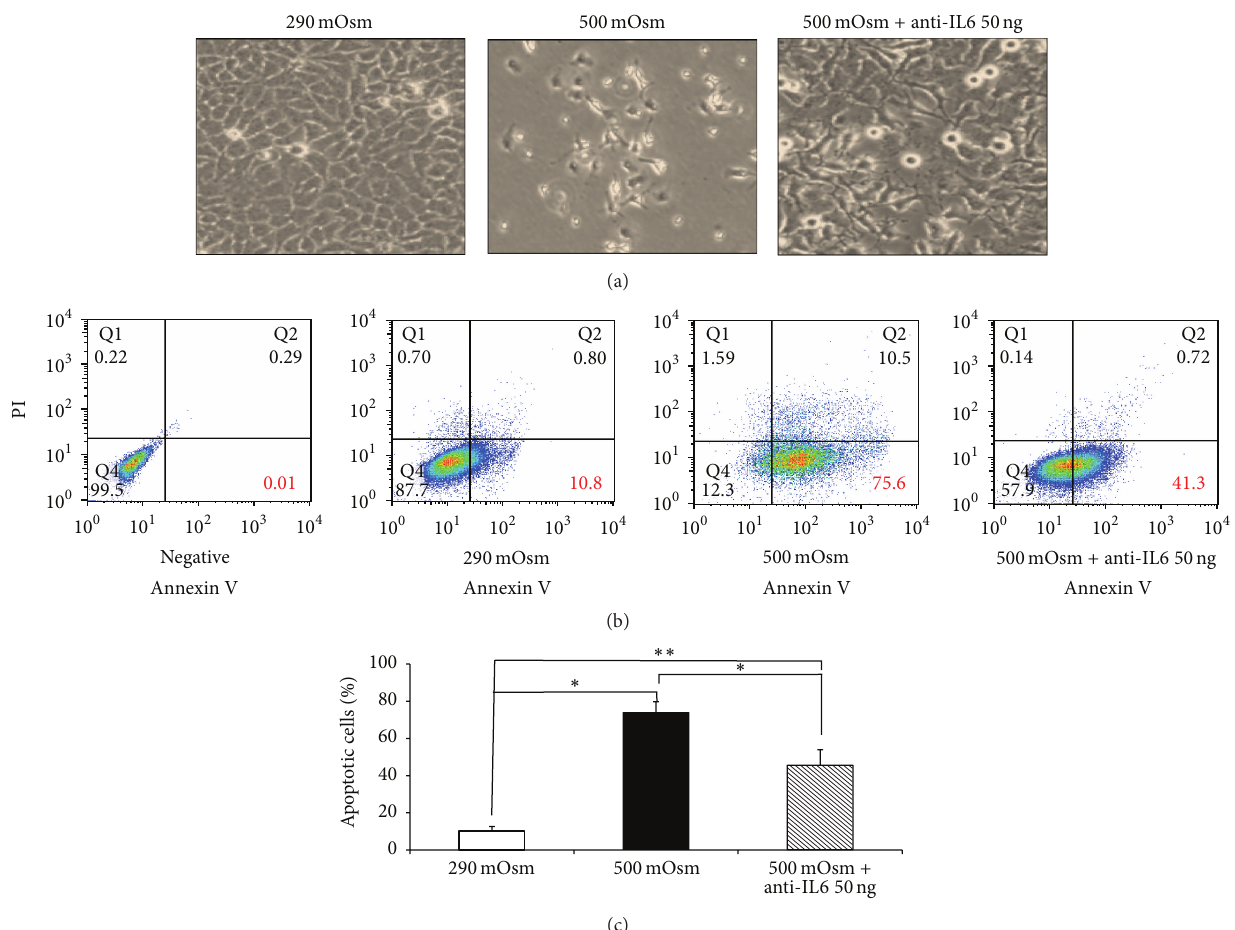
Figure 2: Effect of neutralizing IL6 antibody on cell apoptosis. (a) When evaluating the cell morphology, cell death decreased in 500 mOsm with anti-IL6 treatment. (b) Flow cytometry with Annexin V/PI showed reduced apoptosis under treatment of anti-IL6 and (c) the proportion of apoptotic cells significantly reduced by treatment of anti-IL6. ∗ 𝑝 = 0.022 , ∗∗ 𝑝 = 0.023 , 𝑛 = 3